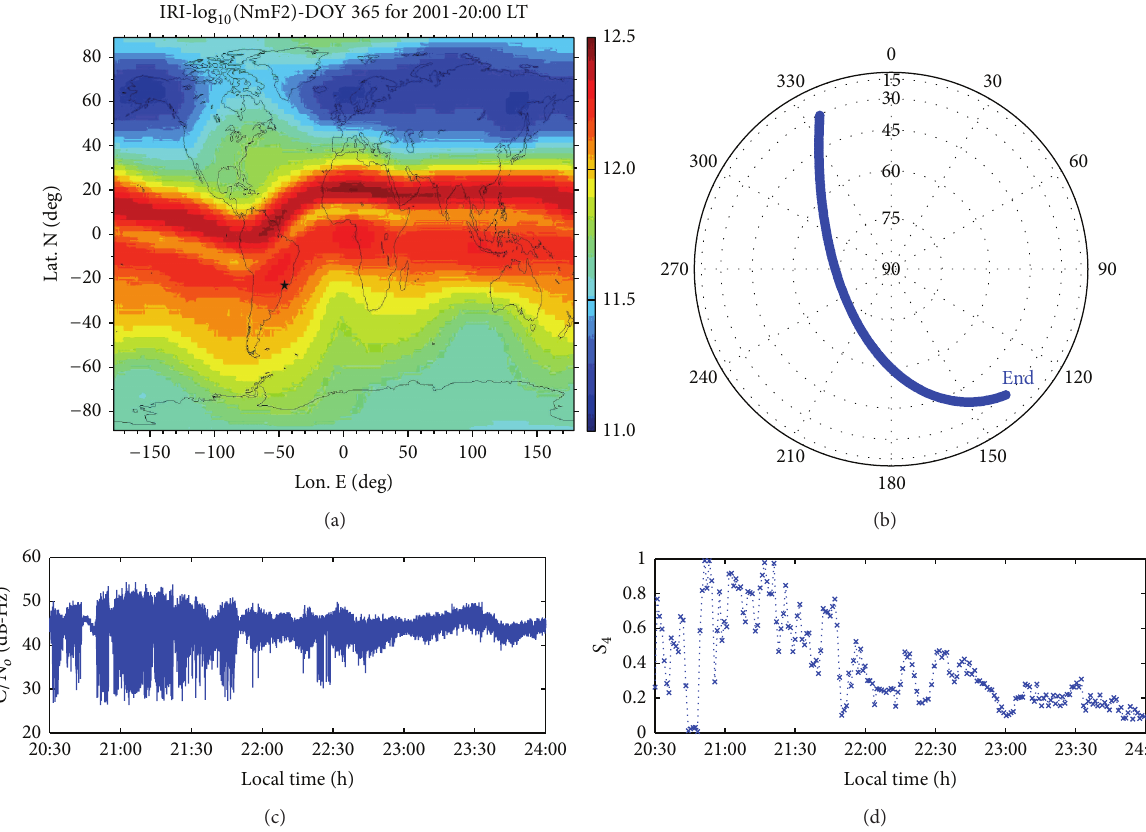
Figure 1: (a) The location of the measurement site SJC overlaid on the global map of the predicted ionospheric maximum electron density (NmF2) at 20:00 LT on December 31, 2001. This map was generated using the international reference ionosphere (IRI) model [26]. (b) Skyplot of satellite PRN 18 on December 15, 2001. (c) Ratio 𝐶/𝑁 𝑜 (dBHz) between the received power and the noise power density corresponding to the link characterized by panel (b). (d) Respective scintillation index 𝑆 4 for consecutive one-minute records of 𝐶/𝑁 𝑜 (3000